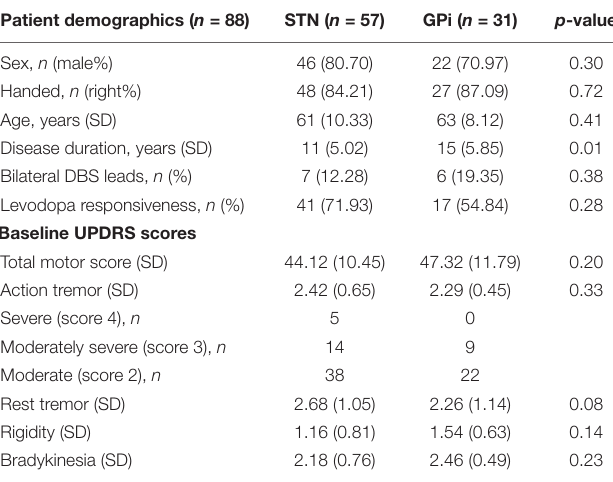
TABLE 1 | Baseline characteristics of Parkinson’s disease patients receiving STN and GPi